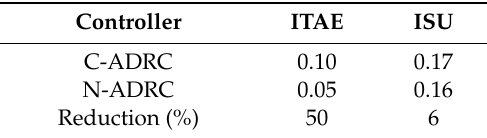
Table 3. Performance